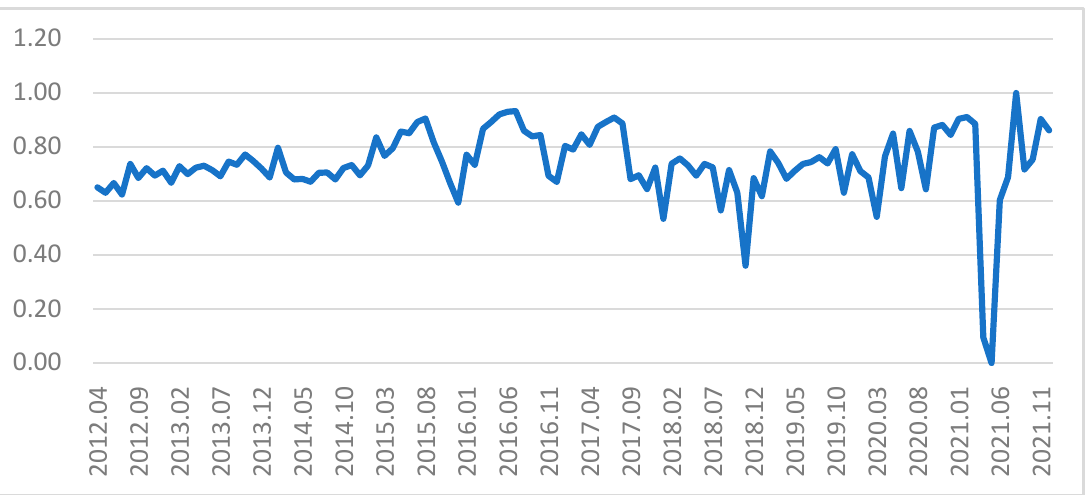
Figure 3. Crisis Index Trend in the Coke and Briquettes Industry.